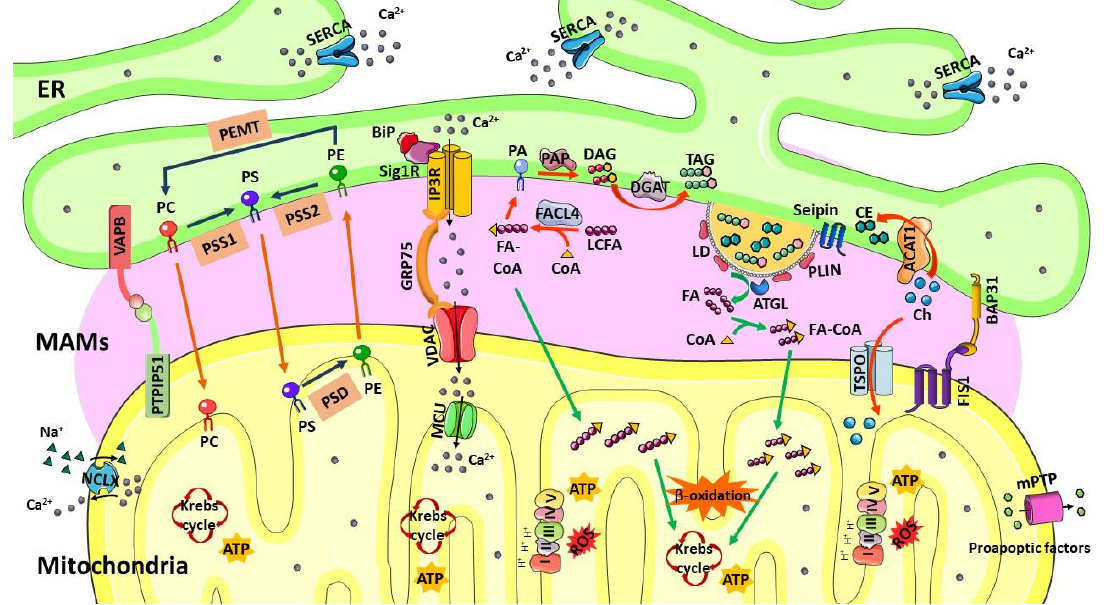
Figure 1. ER – mitochondria tethering and lipid metabolism. Physical interaction between ER and mitochondria is called mitochondria-associated membranes (MAMs) and is formed by several protein complexes, including VAPB-PTPI51, IP3R-GRP75-VDAC, and BAP31-FIS1. This region regulates several cellular functions, such as Ca 2+ signaling and lipid synthesis and trafficking. Ca 2+ released from the ER through IP3R is transported to mitochondria by VDAC and MCU present in OMM and IMM, respectively. GRP75 acts as a linker between IP3R and VDAC and Sig1R interacts with chaperone BiP to stabilize IP3R. Furthermore, MAMs are enriched in proteins involved in lipid metabolism and play an important role in phospholipid transfer from the ER to mitochondria. Phospholipid PC synthetized in the ER can be directly translocated to mitochondria or converted into PS by PSS1 at the ER; then, PS is imported by mitochondria and converted to PE by PSD. The PE synthesized in mitochondria can be transported to the ER and converted to PC or PS by PEMT or PSS2, respectively. At MAMs, protein FACL4 binds CoA to long-chain FAs before fatty acyl-CoA is transported to mitochondria for β -oxidation or used as a precursor for synthesis of PA, which is then converted in DAG. DGAT2 catalyzes synthesis of TAG from DAG, and protein ACAT1 catalyzes synthesis of Ch in CE, which are stored in LDs. Seipin facilitates growth of nascent LDs that are surrounded by PLINs proteins. Lipids stored in LDs can be converted to FA by lipolysis and used for β -oxidation to produce ATP. Cholesterol can also be transported from ER to mitochondria through TSPO protein.